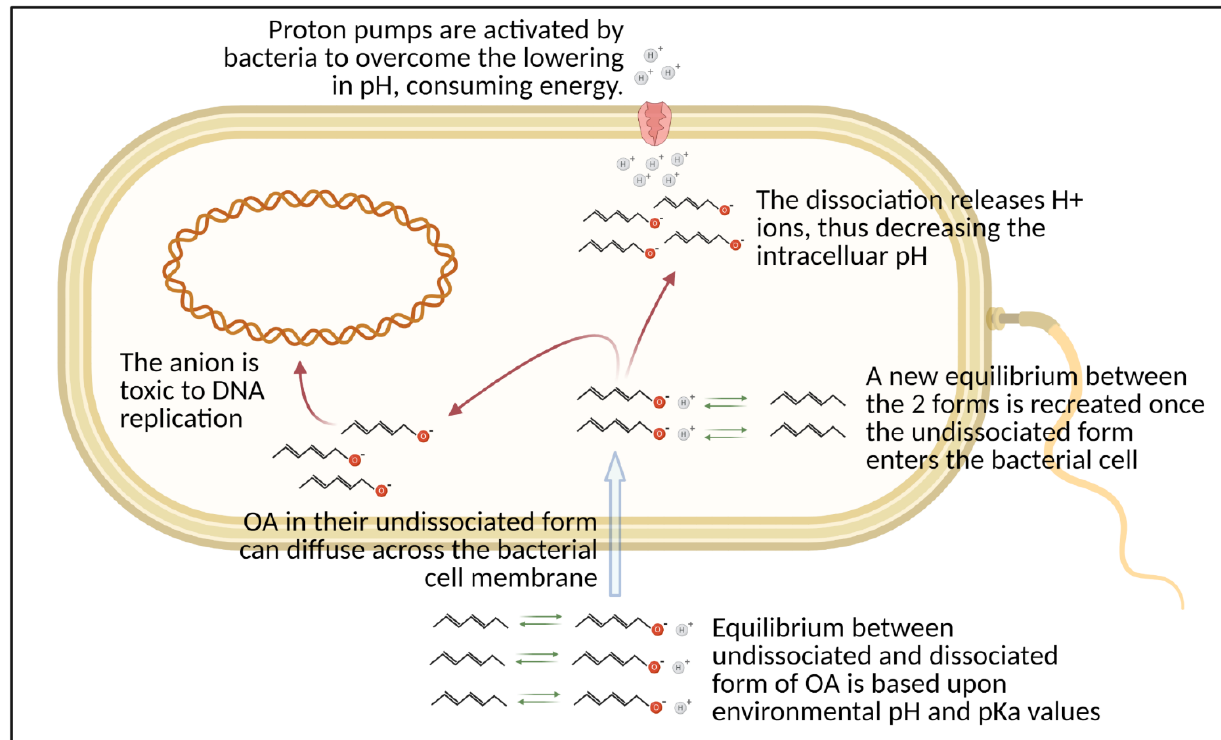
Figure 1. Antimicrobial mode of action of organic acids (OA). The anion model is generally accepted as mode of action for OA. Created with Biorender.com (accessed on 19 April 2021).